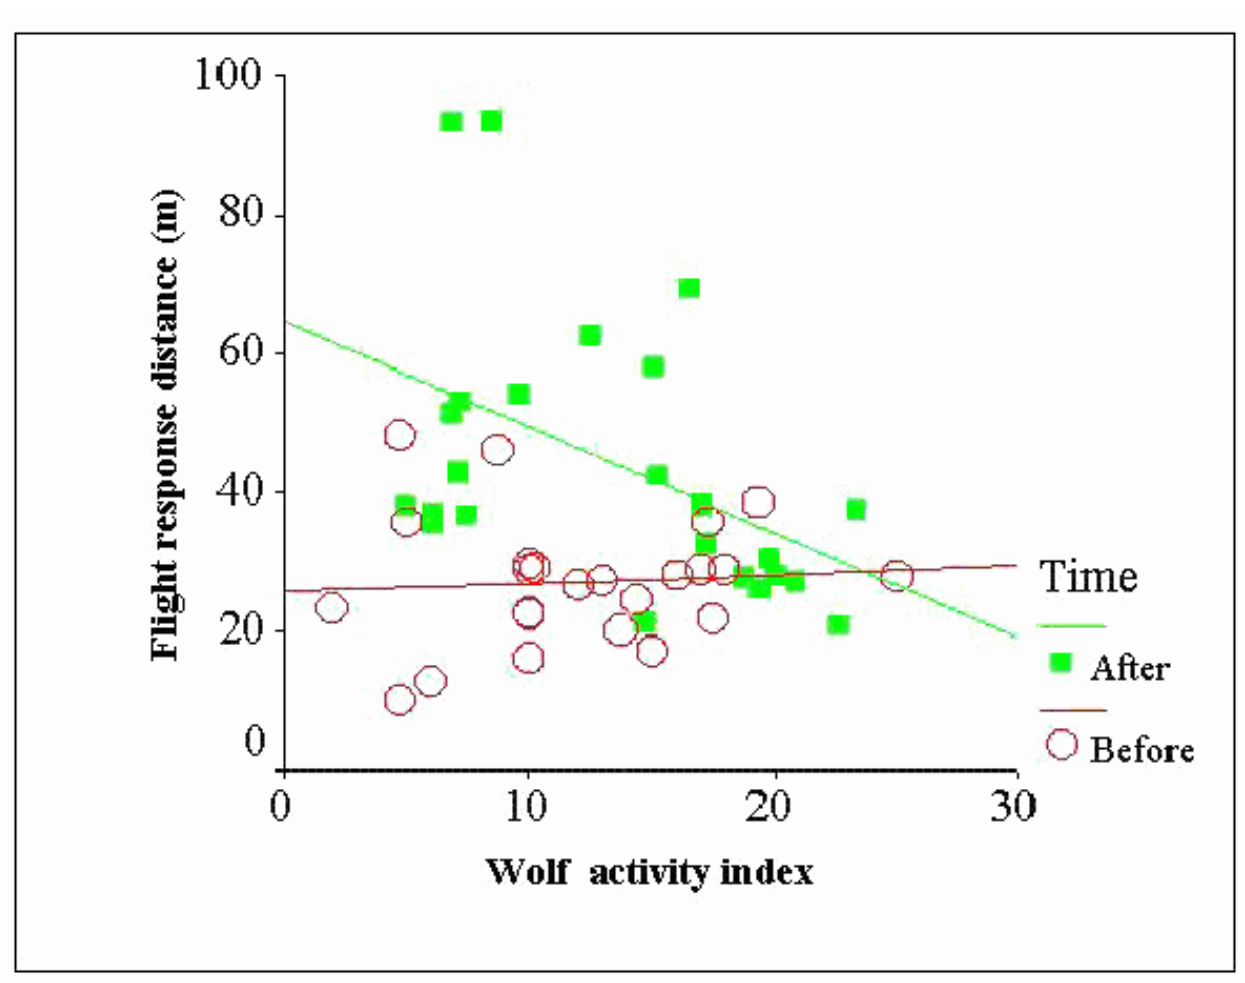
Fig. 3. Relationship between flight response distance and nearby wolf activity for elk before (circle) and after (square) aversive conditioning in Banff National